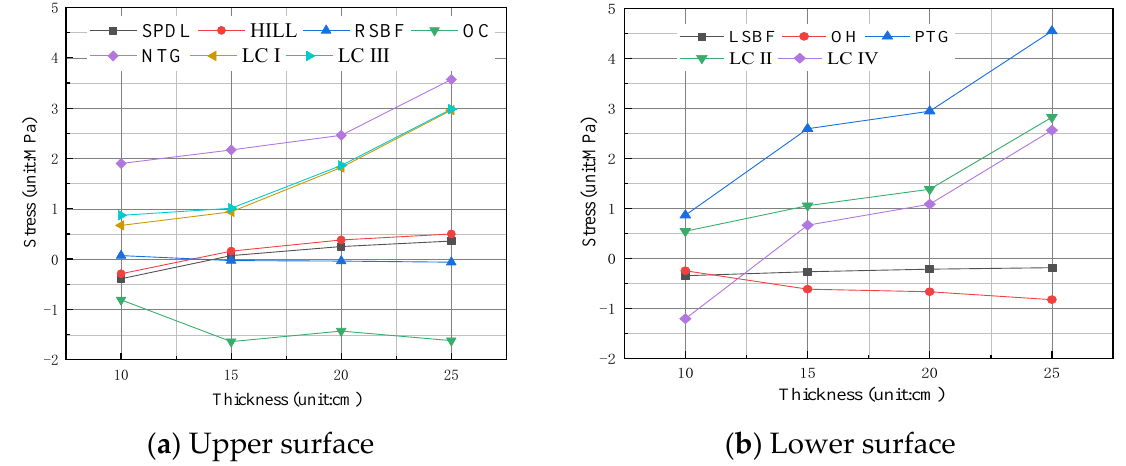
Figure 14. Curve of maximum principal tensile stress vs. thickness of CLS with asphalt concrete surface.